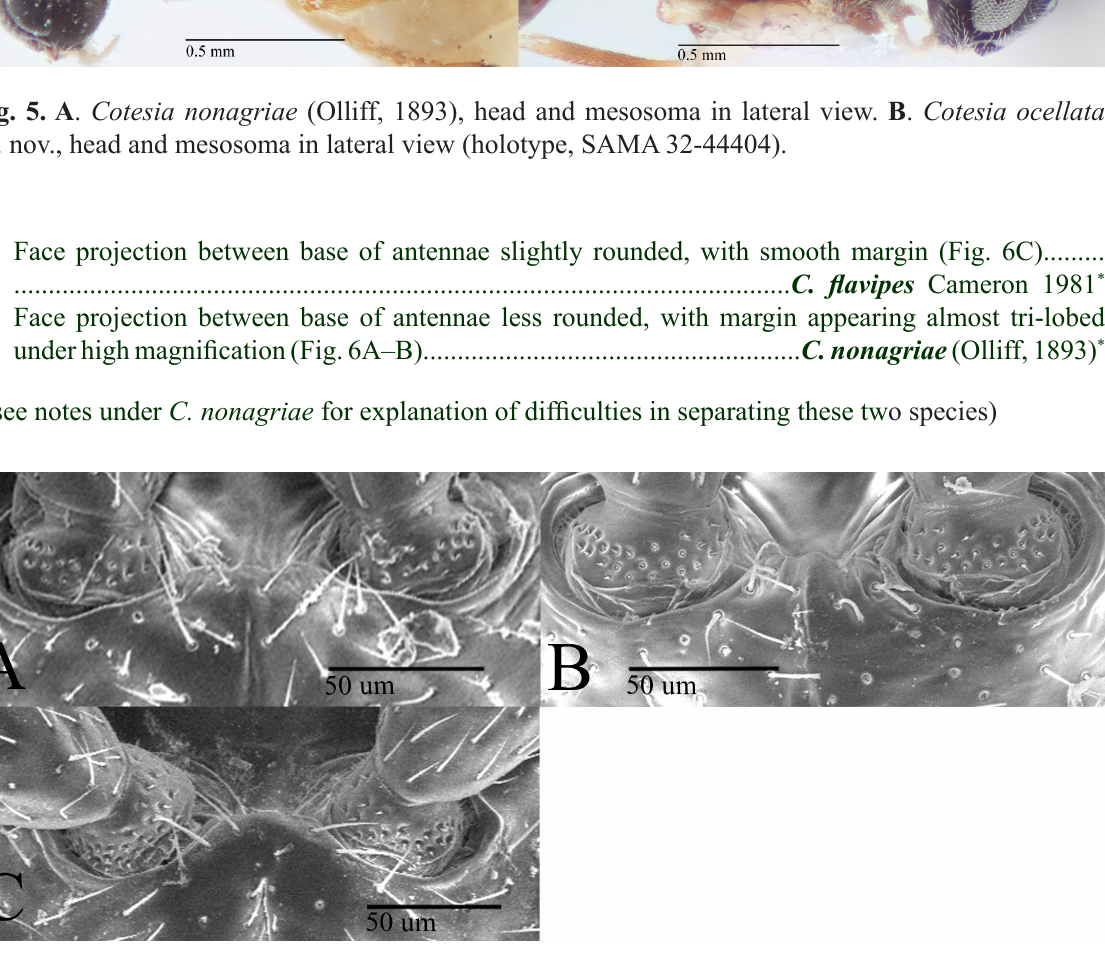
Fig. 6. A . Cotesia nonagriae (Olliff, 1893), Giru, Australia (WINC). B . C. nonagriae , Bundaberg Australia (WINC). C . C. flavipes Cameron 1981, Indonesia